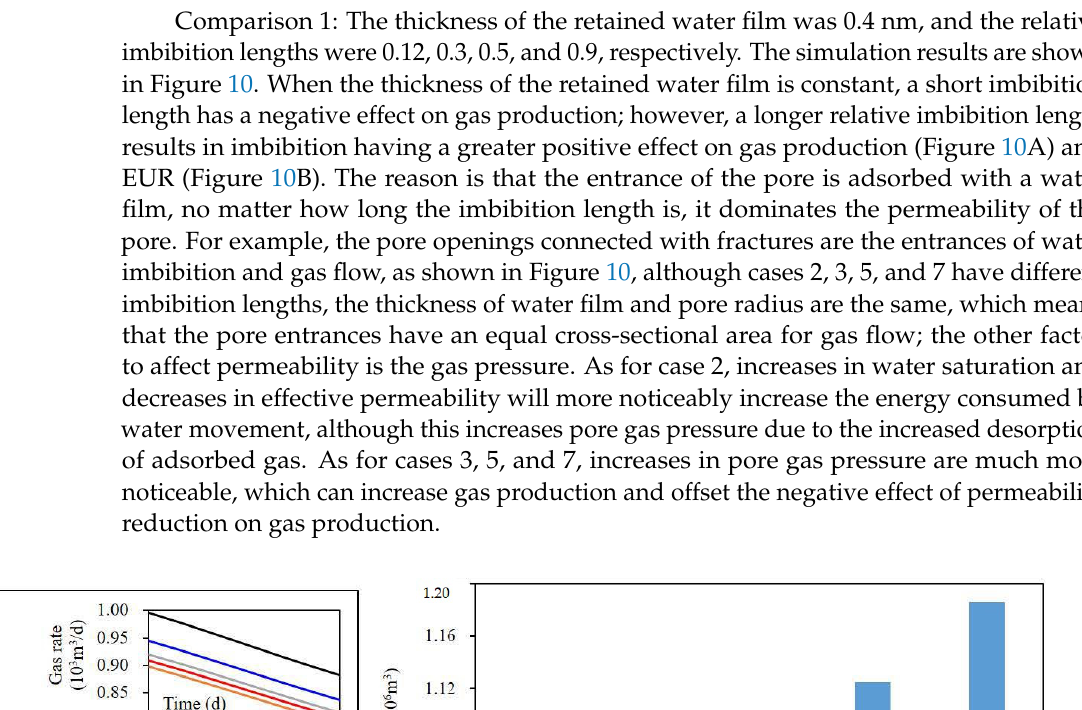
Figure 11. Effect of water film thickness on gas well production, the subfigure is the magnification of the intersection with the ordinate. 5. Conclusions The assumption used in this study is that the bulk water in affected blind pores is discharged. By analyzing the influence of fracturing fluid imbibition on blind pores in the reservoir coal matrix, the following conclusions were obtained through numerical simu- lations: 1.